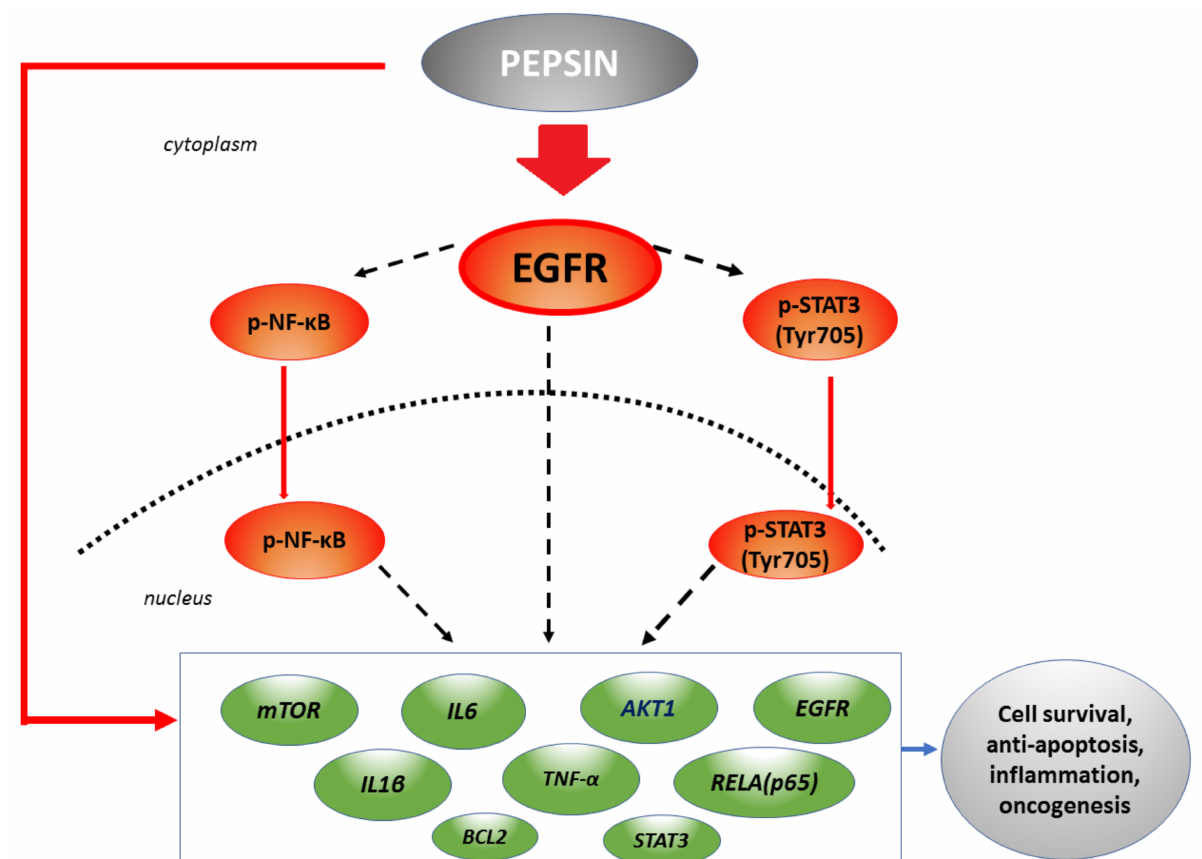
Figure 7. The effect of pepsin on epidermal growth factor receptor (EGFR) and its related signalling pathway in human hypopharyngeal primary cells, at less acidic LPR. Pepsin at slightly acidic or neutral pH causes significant overexpression of EGFR, accompanied by elevated activation of p-NF- κ B and p-STAT3, and a significant overexpression of EGFR-related oncogenic factors and cytokines, including AKT1, mTOR , IL1 β , IL6, TNF- α , STAT3 and RELA(p65), and antiapoptotic BCL2 , previously linked to HNSCC [35,36,39–42,46–48,52]. (red arrows: pepsin effect in HCs; dashed black arrows: possible interactions; green boxes: genes upregulated by